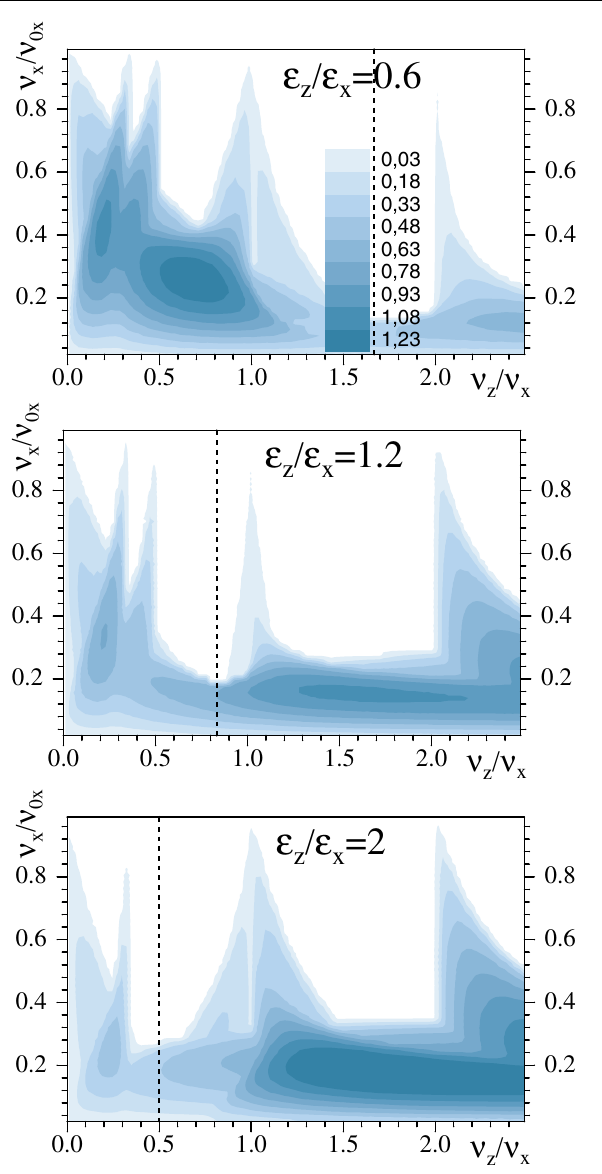
FIG. 11. (Color) Stability charts with analytically calculated stop bands (nonoscillatory modes) for arbitrary (cid:10) =(cid:10) (abscissa), and emittance ratios 0.6, 1.2, nate), tune ratios (cid:10) z x and 2. Growth rates (grey scales in equidistant steps) in units of zero space charge betatron tune (in x ). Dashed lines indicate equipartition tune ratios.